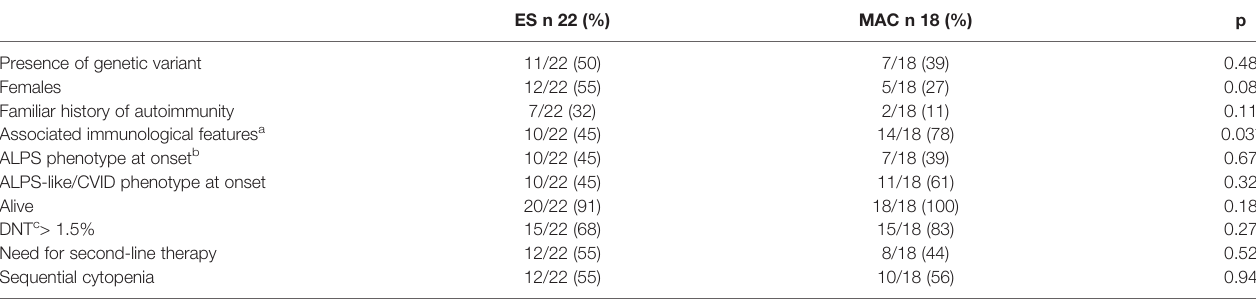
a Celiac disease, presence of autoantibodies including antinuclear, anti-neutrophils, anti-neutrophil cytoplasmic, anti-smooth muscle, anti-thyreoperoxydase, anti-thyroglobulin, lupus anticoagulant, anti-ADAMTS13, extractable nuclear antigen, cold agglutinins. b Presence of required and accessory diagnostic criteria for ALPS. c Double-negative T cells (CD3+ CD4- CD8- TCR ab +). *Statistically signi fi